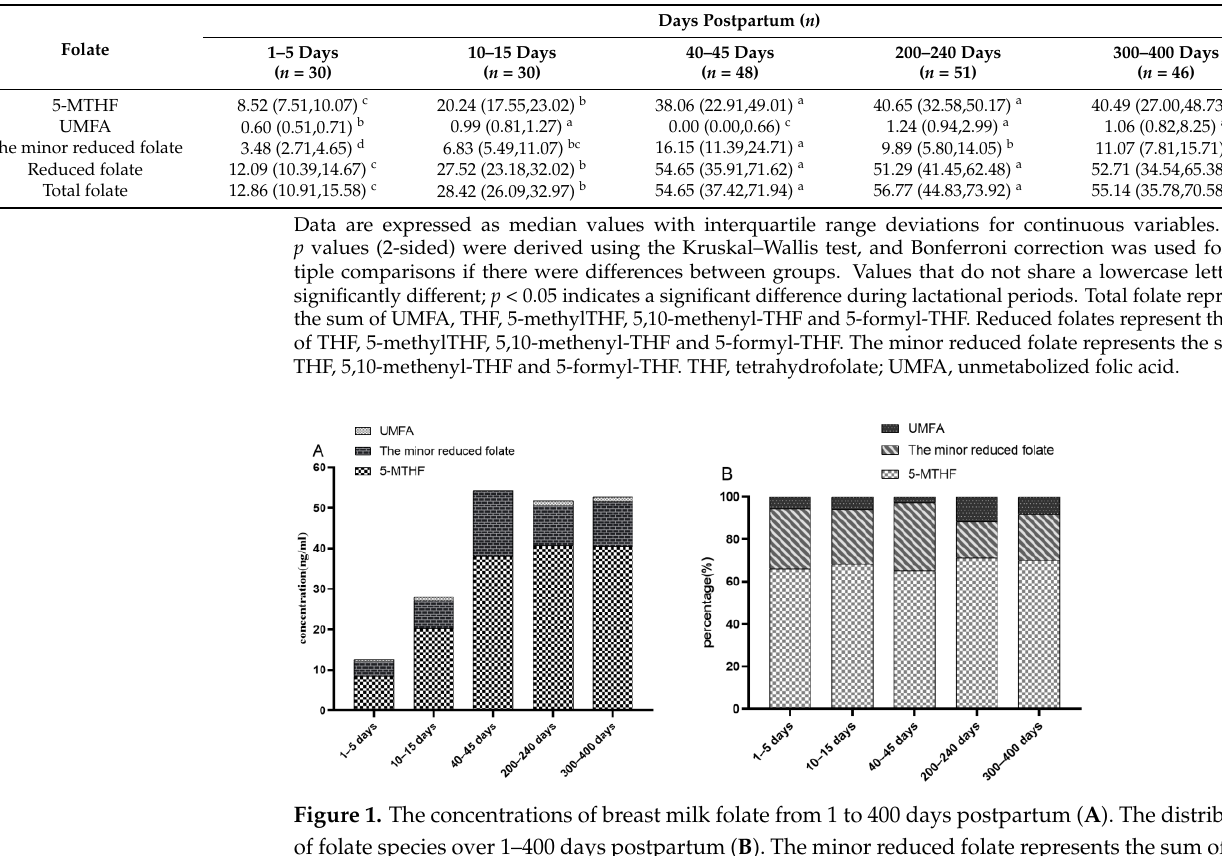
5 - M T H F U M F A M R F